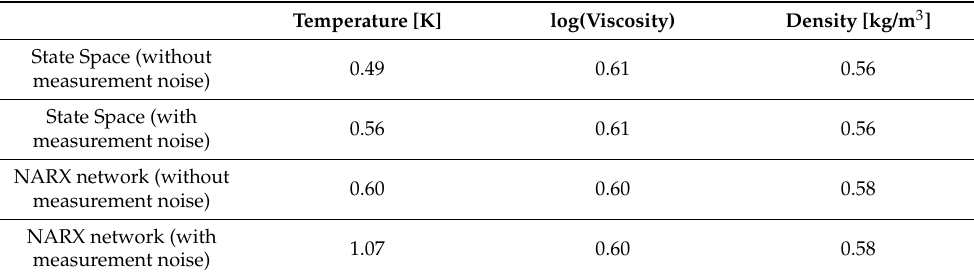
Table 4. Mean NRMSE evaluations between the control and reference